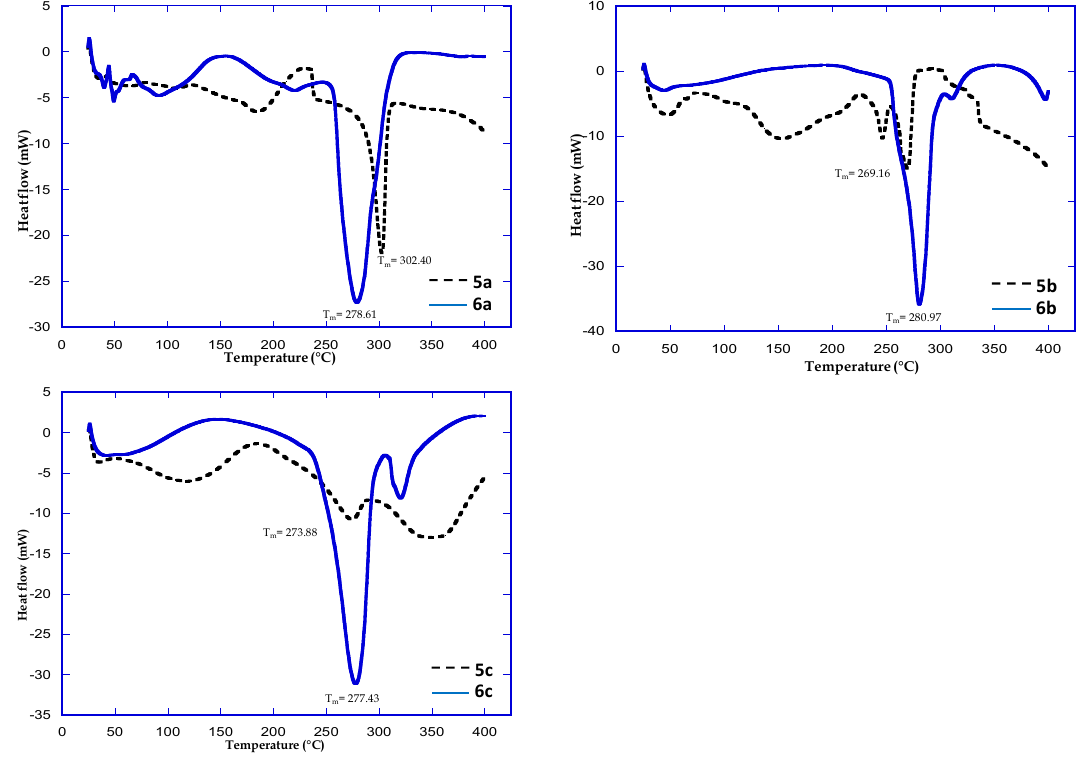
Figure 5. DSC spectra of polymer Compound 5a and 6a , 5b and 6b and 5c and 6c .